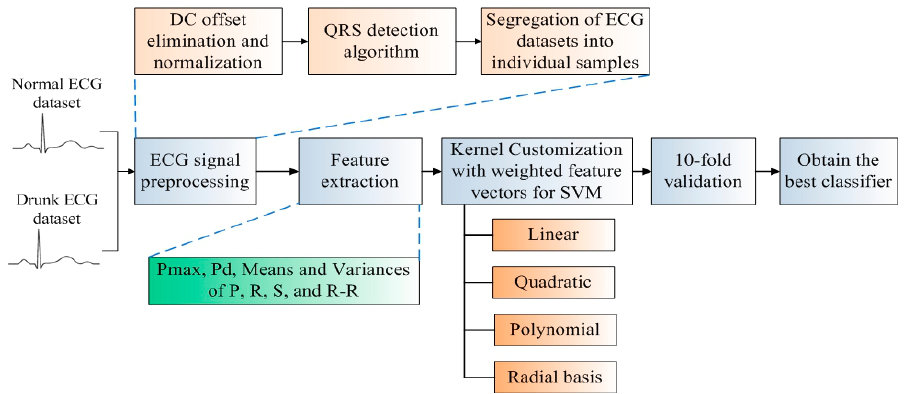
Figure 1. Classifier development flow of electrocardiogram drunk driving detection (ECG-DDD).